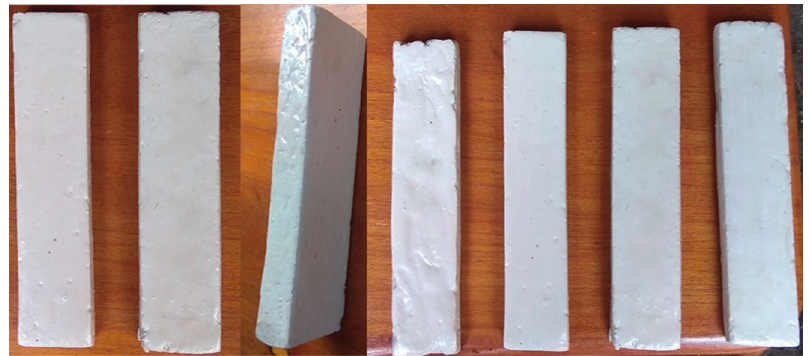
Figure 2: Wood sawdust-reinforced polypropylene composites.